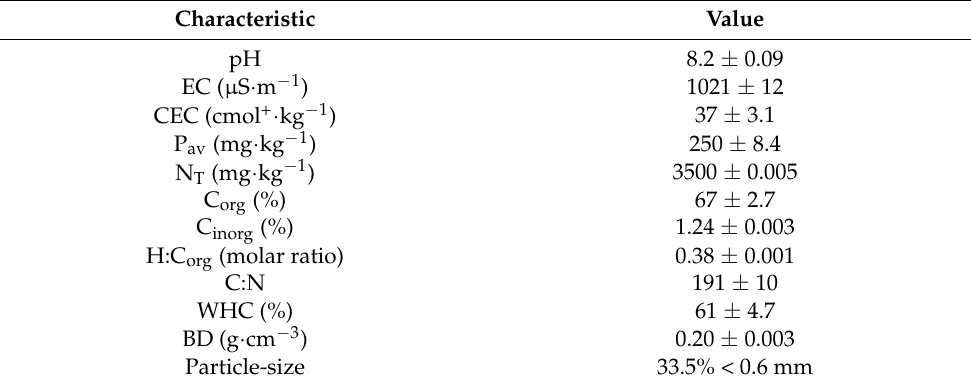
Table 1. Characteristics of biochar added to